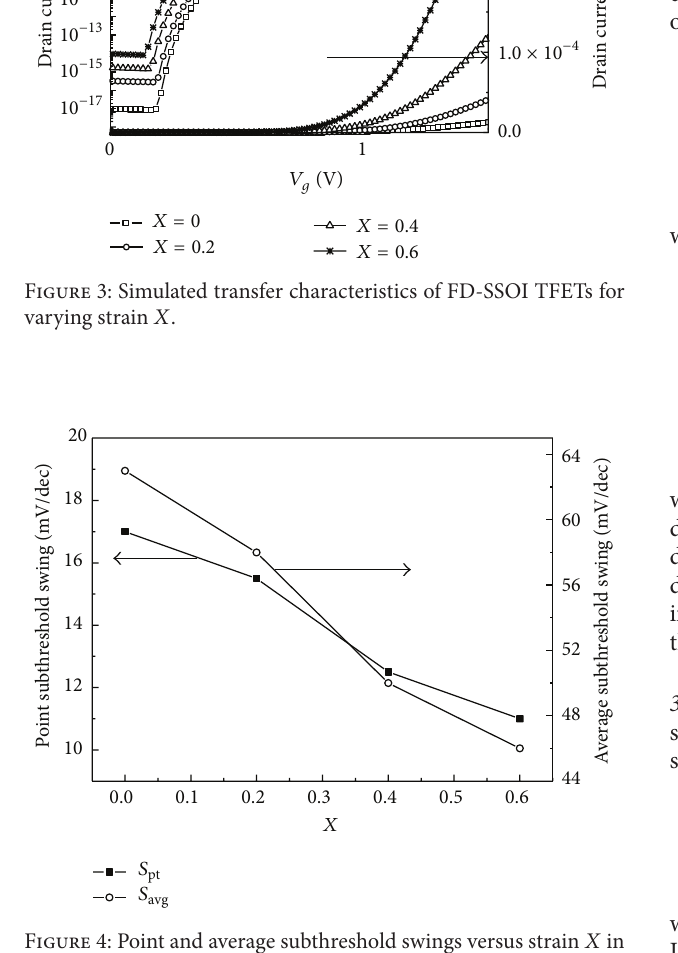
Figure 4: Point and average subthreshold swings versus strain 𝑋 in FD-SSOI TFETs.